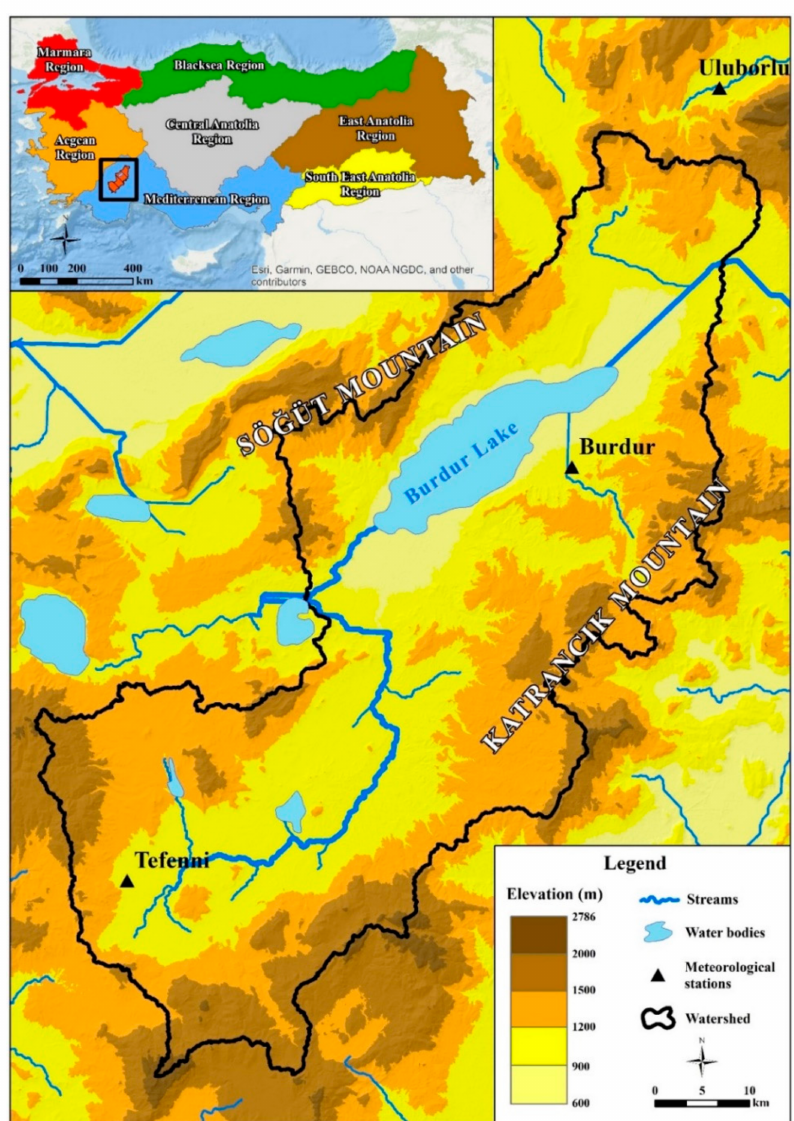
Figure 1. Location of Burdur Lake in Turkey and the local